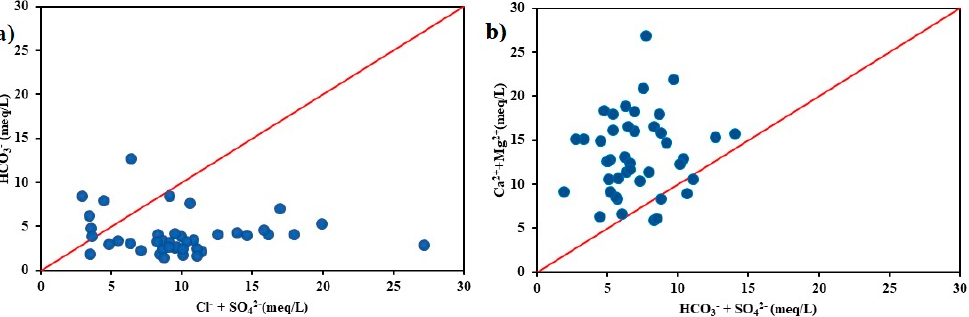
Figure 10. Ionic relationships of ( a ) HCO 3 − vs. (Cl − +SO 42 − ) and ( b ) (Ca 2+ +Mg 2+ ) vs. (HCO 3 − +SO 42 − ).